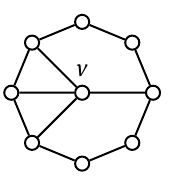
Godsil-McKay switching puts conditions on the graph G and the switching set to create a pair of